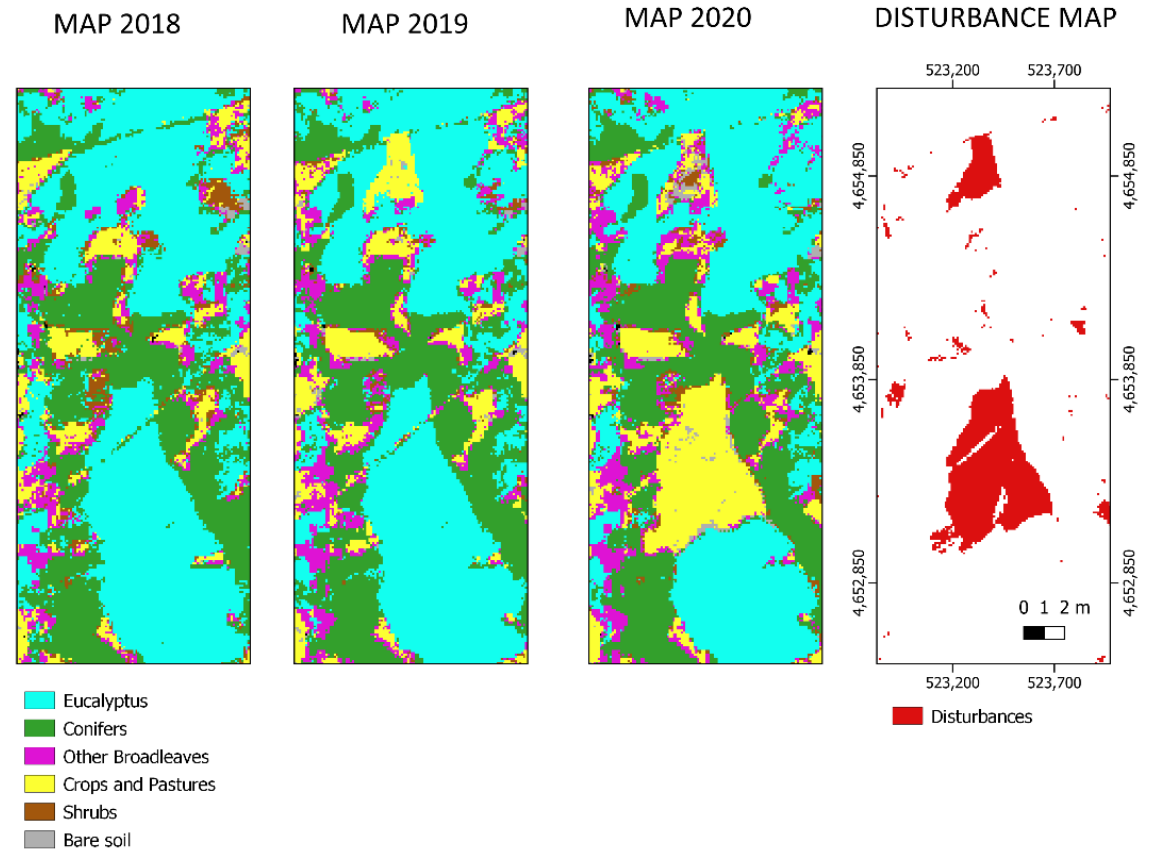
Figure 4. Land cover map of 2018, 2019, 2020 and disturbances map.